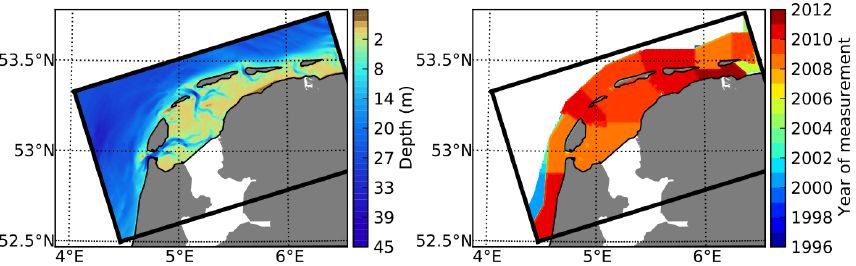
Figure 2. (a) Numerical domain and bathymetry. (b) Dates of the measurements used to compose the bathymetry up to the 20m isobath in the North